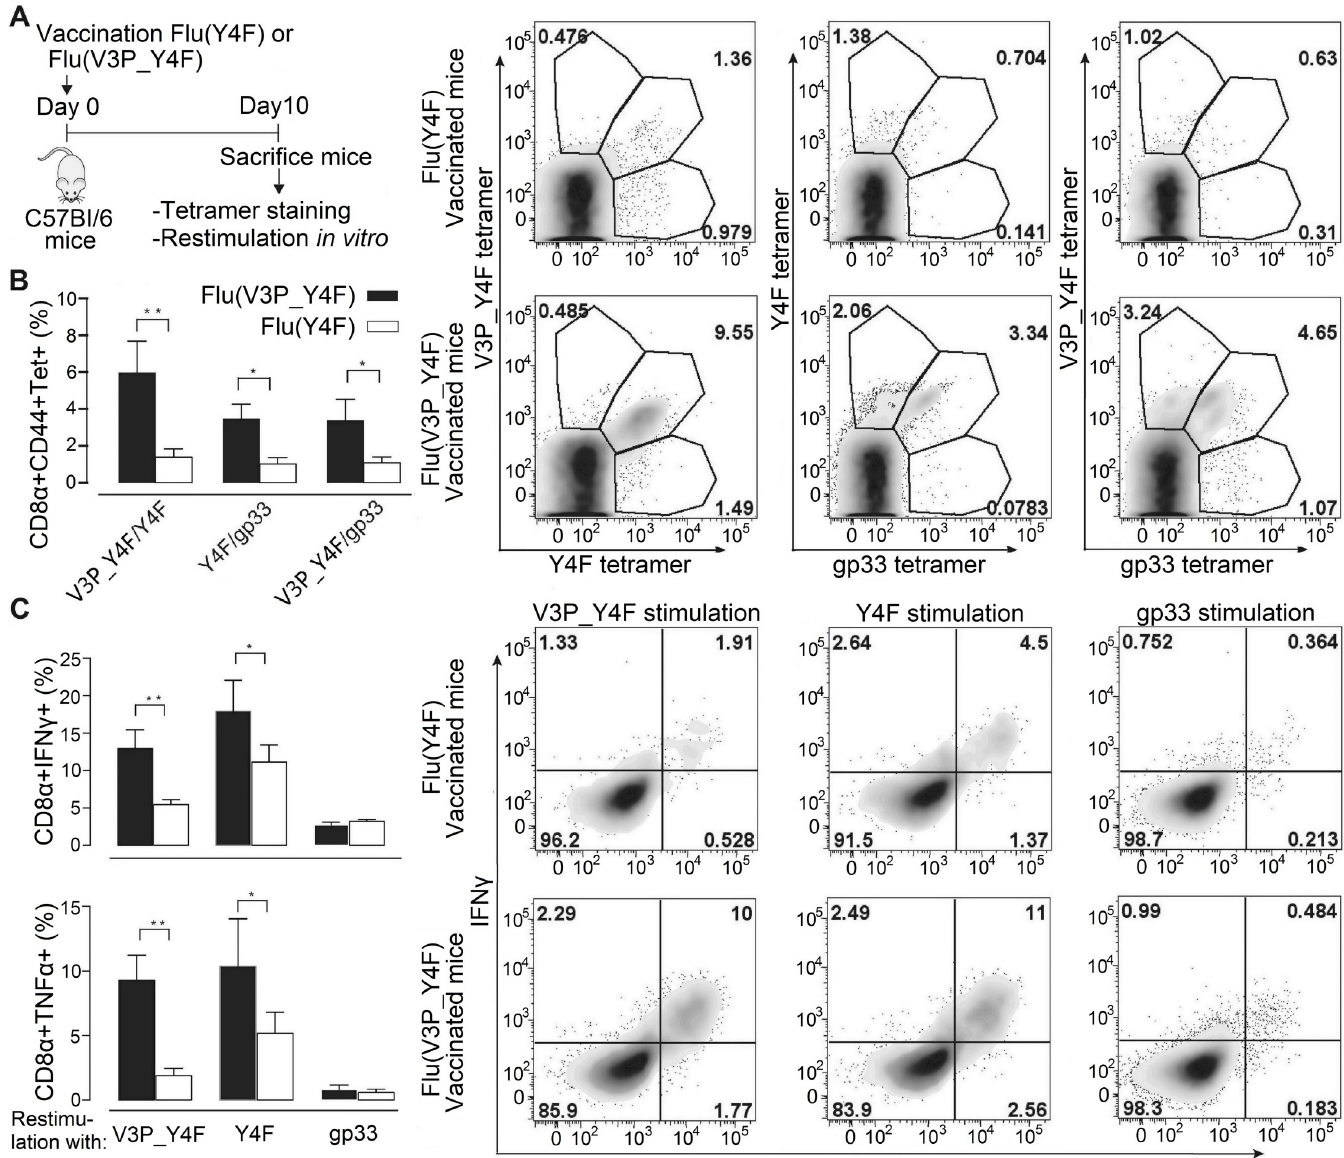
Fig 3. Vaccination of C57/Bl6 mice with influenza virus encoding for V3P_Y4F re-established efficient recognition of the immune escape variant Y4F. The escape mutant Y4F (KAV F NFATM) and the proline-modified variant V3P_Y4F (KA PF NFATM) were engineered into the stalk region of neuraminidase of the Influenza A virus strain HKx31 (H3N2), and used to infect C57BL/6 mice. A. C57/Bl6 mice infected with either flu(Y4F) or flu(V3P_Y4F) were sacrificed day 10 post infection. B. CD8 + CD44 + cells were stained with combinations of H-2D b /gp33, H-2D b /Y4F or H-2D b /V3P_Y4F tetramers. Data represents double positive tetramer populations. Right top panel: Representative density plots of CD8 + CD44 + T-cells from mice infected with flu(Y4F) or flu(V3P_Y4F). Data from pooled 4–5 mice, representative of two different experiments. C. Cells were also stimulated with gp33, Y4F or V3P_Y4F peptides for 5 h, and intracellular IFN γ and TNF expression was determined. (Right bottom panel) CD8 + CD44 + T-cells isolated from mice infected with flu(Y4F) or flu(V3P_Y4F) were stimulated with either gp33, Y4F or V3P_Y4F (10 − 6 M), and thereafter stained for INF γ and TNF. Data of IFN γ and TNF secretion from pooled 4–5 mice representative of two different experiments. Error bars show mean +/- SD. Statistical significance is presented with the p-value from a two-way Anova with Sidak’s multiple comparison test. � represents p < 0.05; �� represents p < 0.01. The analyses were performed using the GraphPad Prism